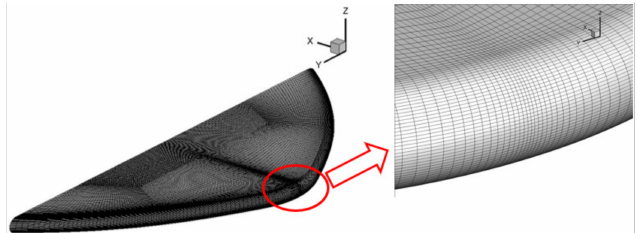
Figure 8. Diagram of the stagnation point heat flow